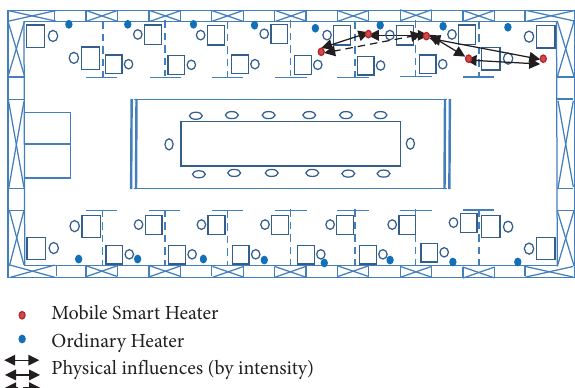
Figure 1: An example of the open ofce plan with heater